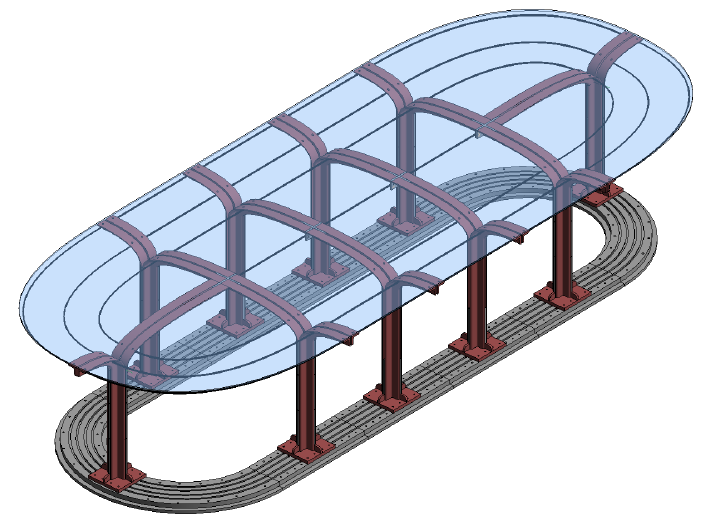
Figure 18. Spatial form of a single central building.